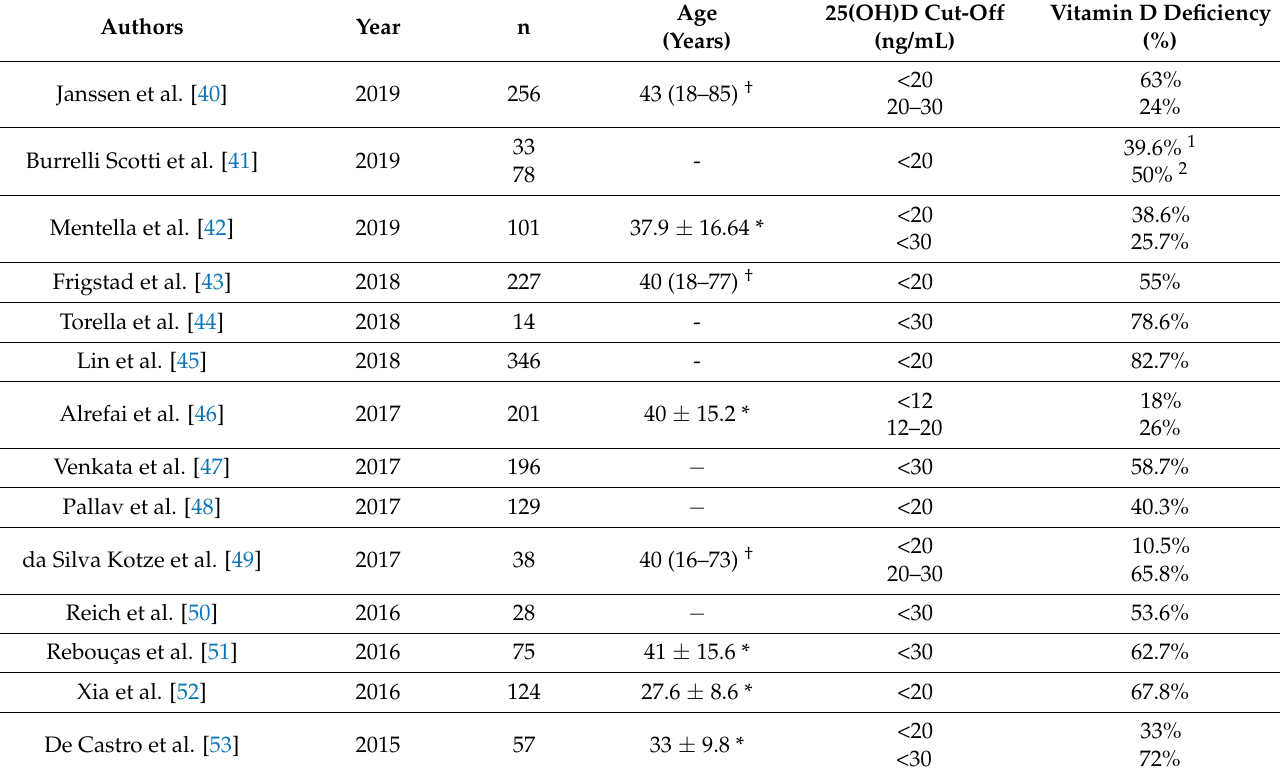
Table 3. Prevalence of Vitamin D deficiency in Crohn’s Disease